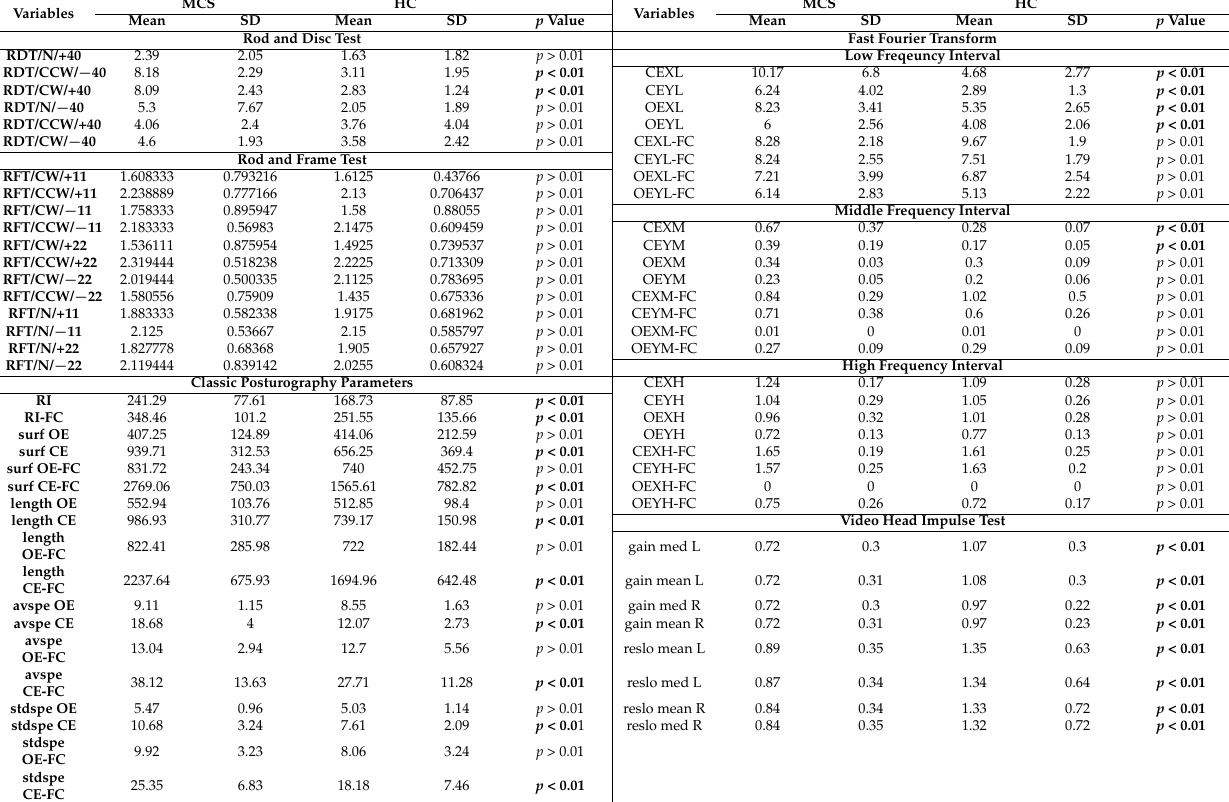
Table 2. Otoneurological scores in MCS and HC